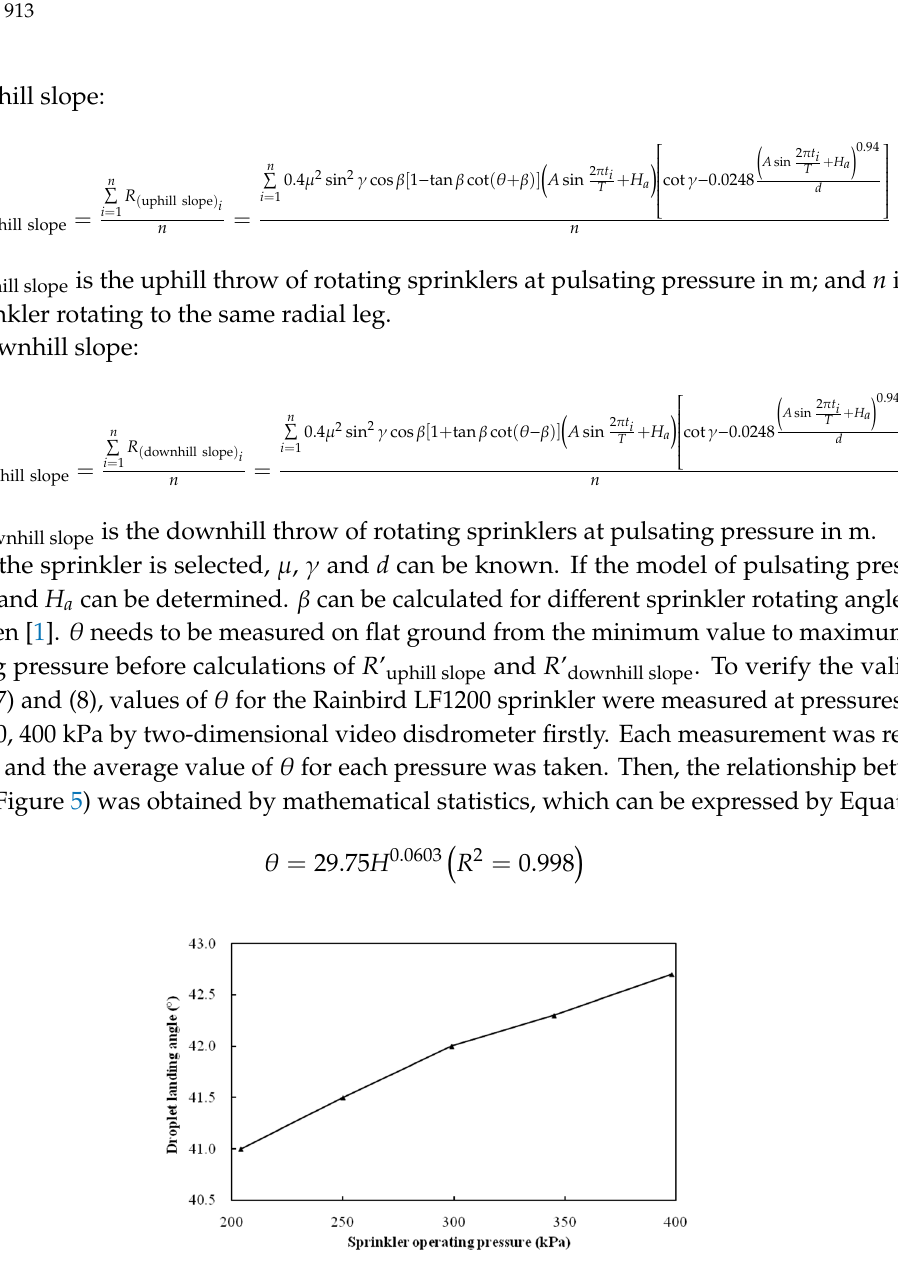
Figure 5. The relationship between droplet landing angle and sprinkler operating pressure.